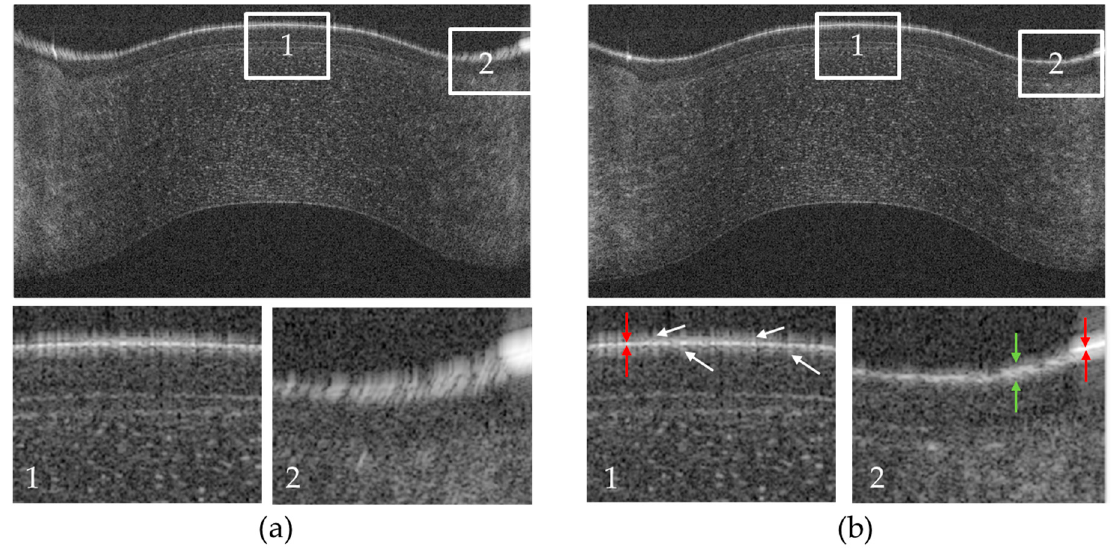
Figure 2. Representative B-scan of the cornea recorded with the instrument in the co-polarized detection channel. ( a ) Without variable dispersion compensation (fixed parameter over the entire B-scan) dispersion is clearly visible at the periphery of the cornea; ( b ) B-scan evaluated with variable dispersion compensation. The lower row shows magnified views (3 × ) of the regions of interest (1,2) that are marked with white rectangles in the upper row. White arrows point to artefacts at the corneal surface. Red arrows indicate the axial point spread function. Green arrows indicate a thickening of the topmost layer of the epithelium. The field of view of the large images is 11 mm (x) and 867 µ m (z).